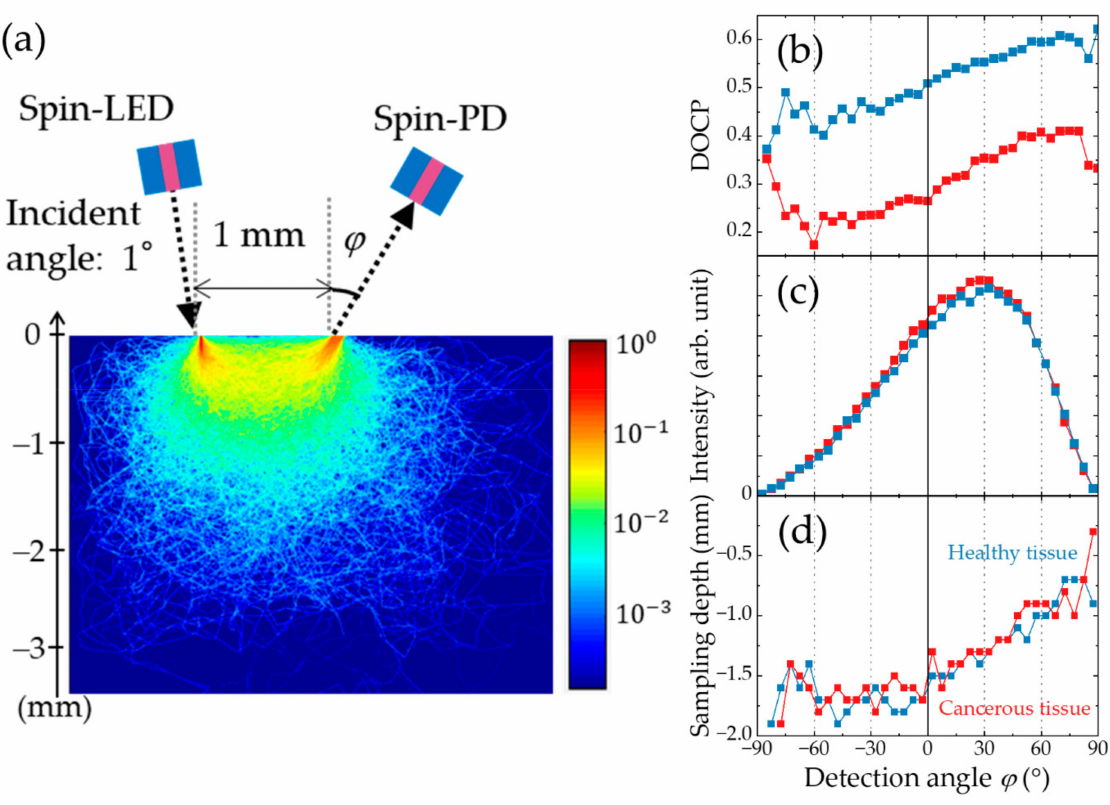
Figure 11. ( a ) Monte Carlo simulation geometry for multiple scattering in pseudo biological tissues, together with the calculated distribution of simulated light beam paths under the condition that φ = 25 ± 5 ◦ and the number of photons is 500,000. φ dependence of ( b ) DOCP, ( c ) intensity, and ( d ) sampling depth for pseudo-healthy tissues ( a = 5.9 µ m: blue plots and lines) and pseudo-cancerous tissues ( a = 11.0 µ m: red plots and lines). Reproduced with permission from